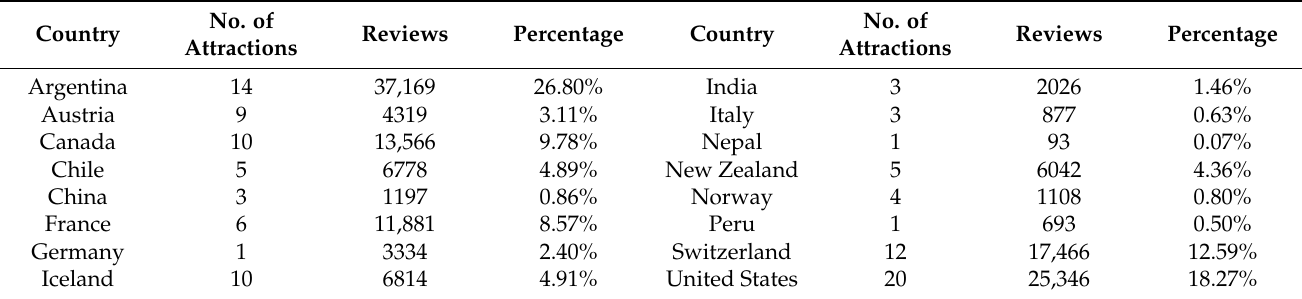
Figure 1. Location of the glacier tourist attractions. (The boxes indicate the name of the glacier, the abbreviation of the country, and the number of comments from visitors. Data from https://www.tripadvisor.com/ (accessed on June 12, 2022)). Table 1. Descriptive statistics of collected glacier travel reviews.